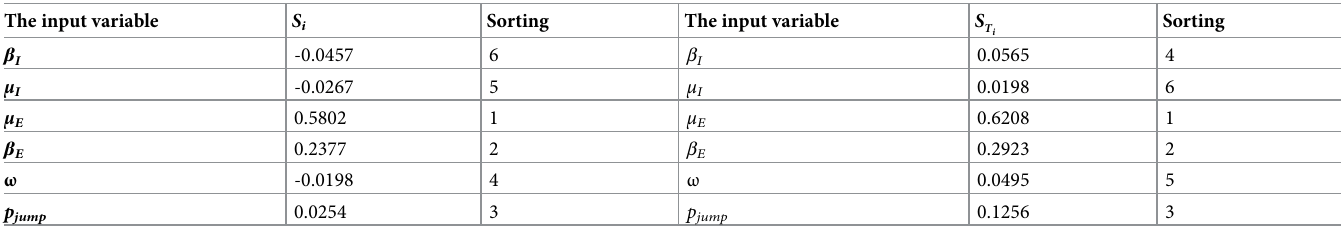
Table 8. Sensitivity index of each variable to ρ